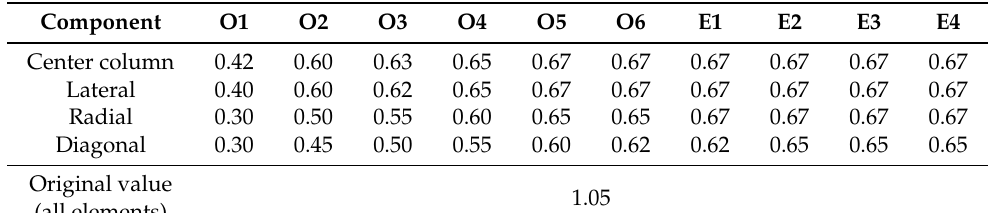
Figure 7. Drag coefficients as a function of the Reynolds number as defined in [24] for the largest ( right ) and smallest ( left ) diameter. The dotted lines indicates the sea states. Table 5. Updated drag coefficients applied for each element of the TetraSpar in the investigated sea